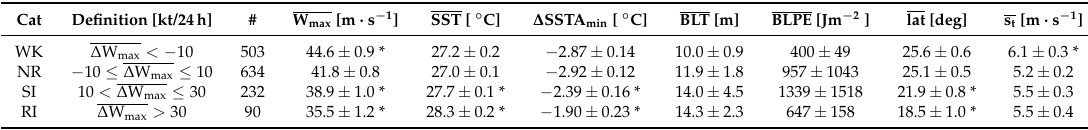
Table 4. Relationship between hurricane and ocean properties and hurricane intensification for four categories: NR (neutral response), RI (rapid intensification), SI (slow intensification) and WK (weakening). The definition of each category is described in the second column considering the variation of W max (referred to as ∆ W max ) and unit of kt/24h (1kt ≈ 0.51m · s − 1 ). s t is the mean hurricane moving speed and lat the mean hurricane latitude. The asterisk (*) indicate those values that present a significant difference (at 95%, based on Welch’s unpaired t -test), with respect to the corresponding NR values. SST is derived from the merged SST